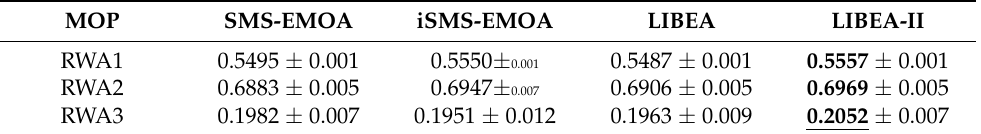
Table 5. Average H n values for the non-dominated solutions found by the IBEAs to each real- world application.